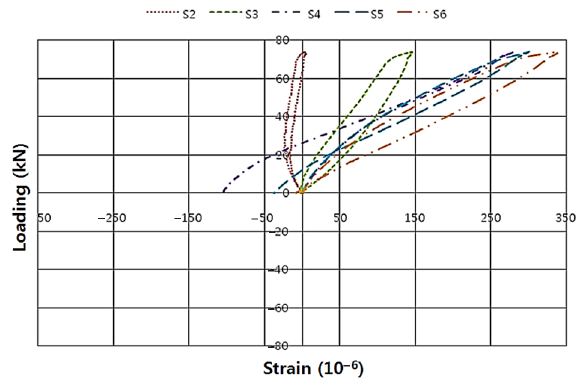
Fig. 11. Strain curves of anchoring rebar under eccentric load